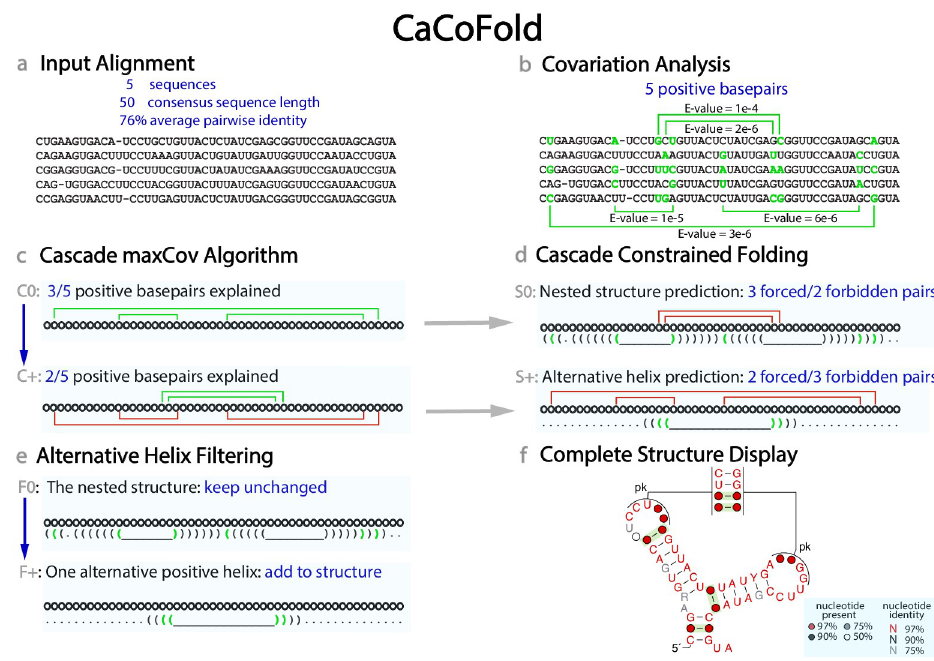
Fig 1. The CaCoFold algorithm. (a) Toy alignment of five sequences. (b) The statistical analysis identifies five significantly covarying position pairs in the alignment (E-value < 0.05). Column pairs that significantly covary are marked with green arches, compensatory pairwise substitutions including G:U pairs are marked green relative to consensus (black). (c) The maxCov algorithm requires two layers to explain all five covariations. In the first (C0) layer, three positive basepairs depicted in green are grouped together. In successive layers (C+), positive basepairs already taken into account (depicted in red) are excluded. (d) At each layer, a dynamic programming algorithm produces the most probable fold constrained by the assigned positive basepairs (green parentheses), to the exclusion of all negative basepairs and other positive basepairs (red arches). (This toy alignment does not include any negative basepairs.) Residues forming a red arch can pair to other bases. Basepairs that do not significantly covary are depicted by black parentheses. (e) The S+ alternative structures without positive basepairs that overlap in more that half of their residues with the S0 structure are removed. Alternative helices with positive basepairs are always kept. (f) The final consensus structure combining the nested S0 structure with the alternative filtered helices from all other layers is displayed automatically using a modified version of the program R2R. Positive basepairs are depicted in